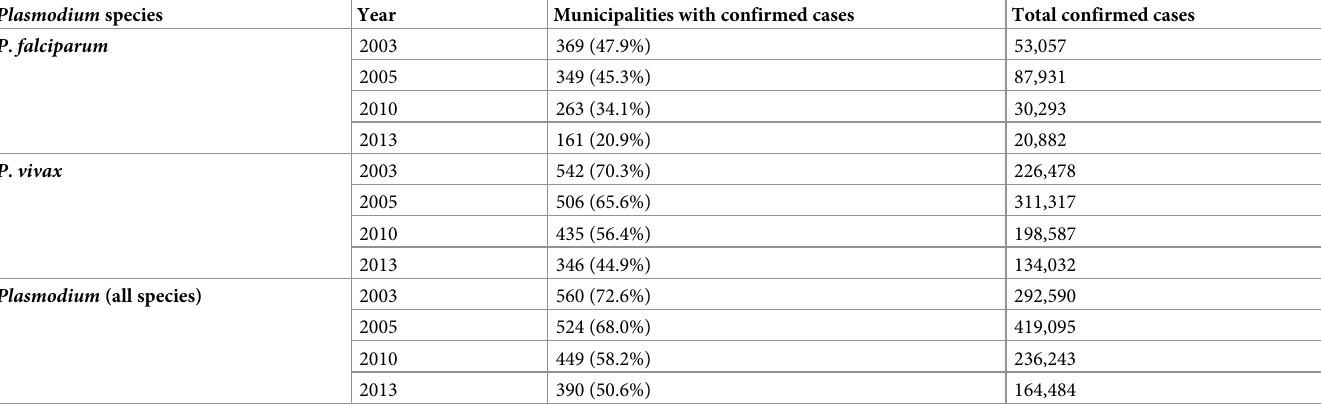
Table 1. Number of municipalities with Malaria cases records by Plasmodium species between 2003 and 2013. Plasmodium species